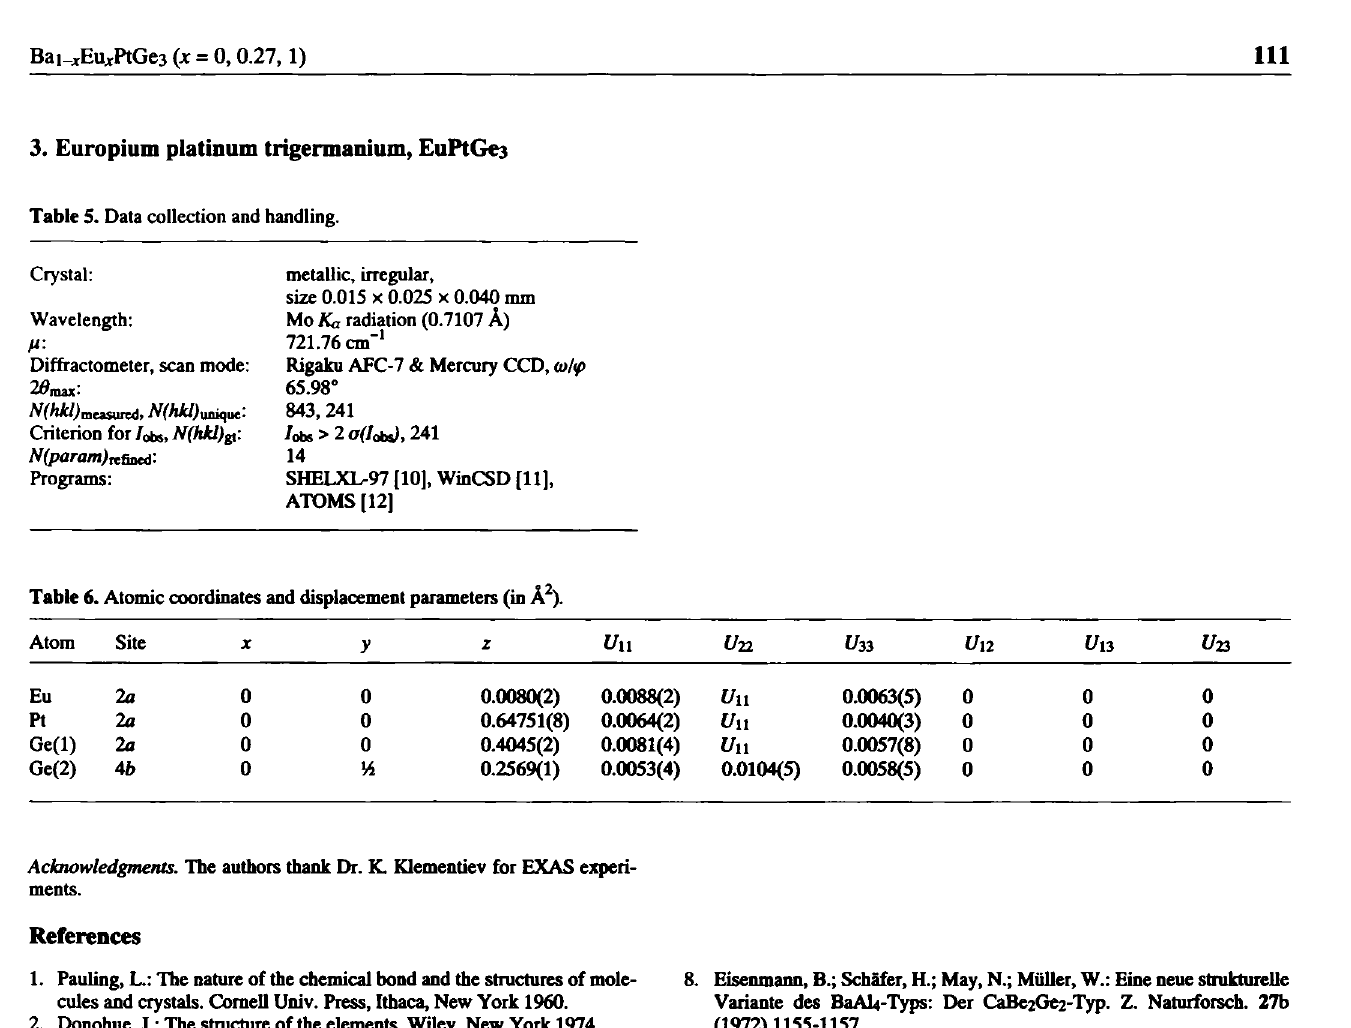
Table 6. Atomic coordinates and displacement parameters (in A 2